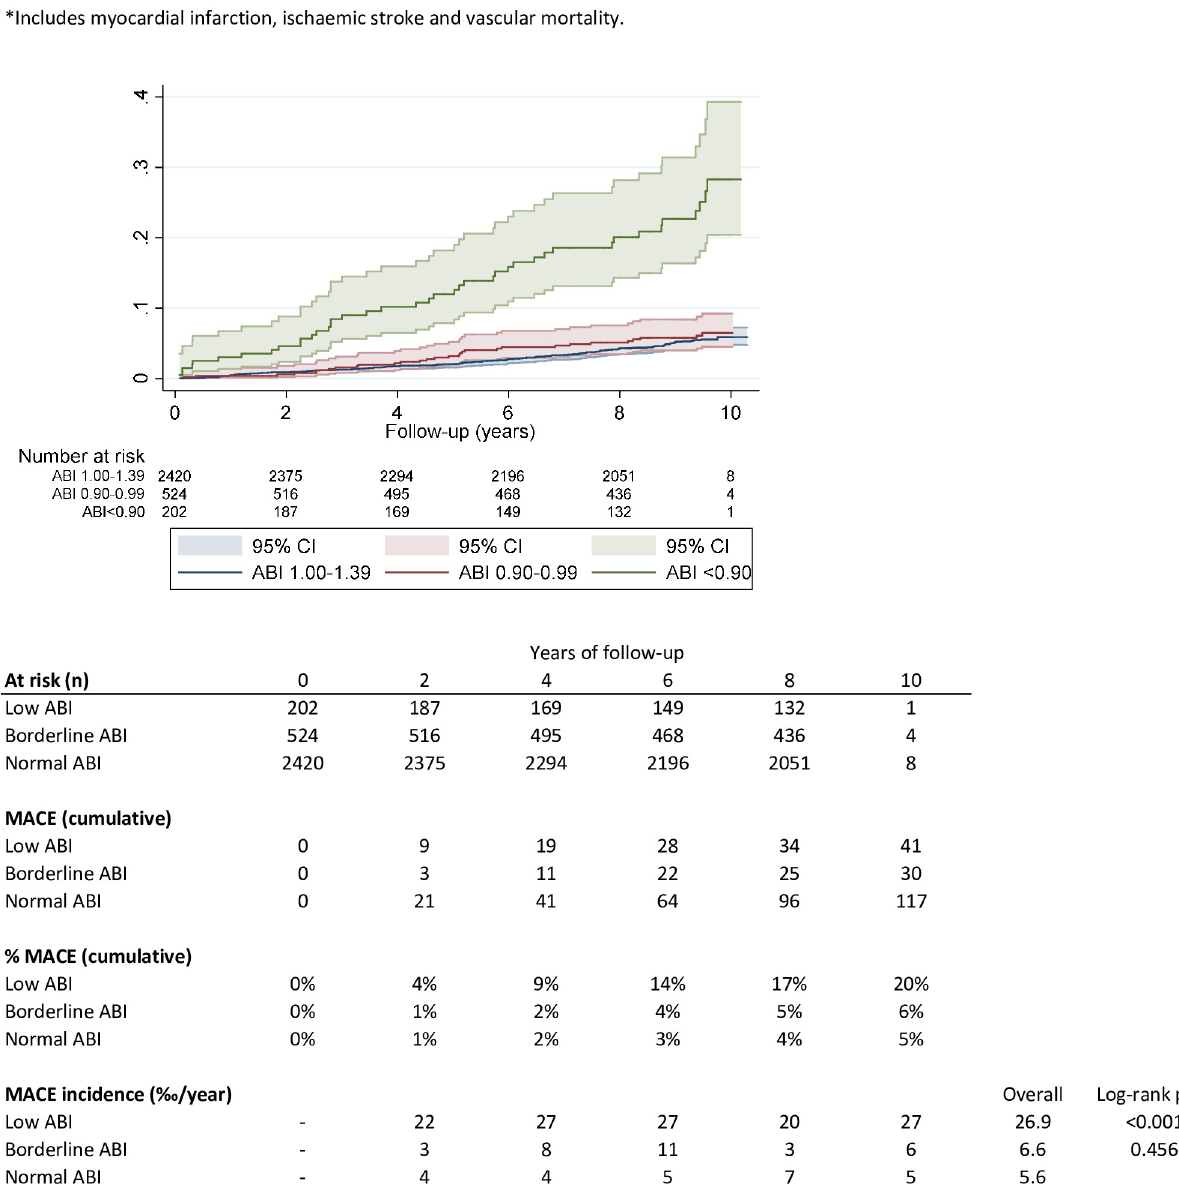
Fig 2. Cumulative hazard of MACE for lower, borderline and normal